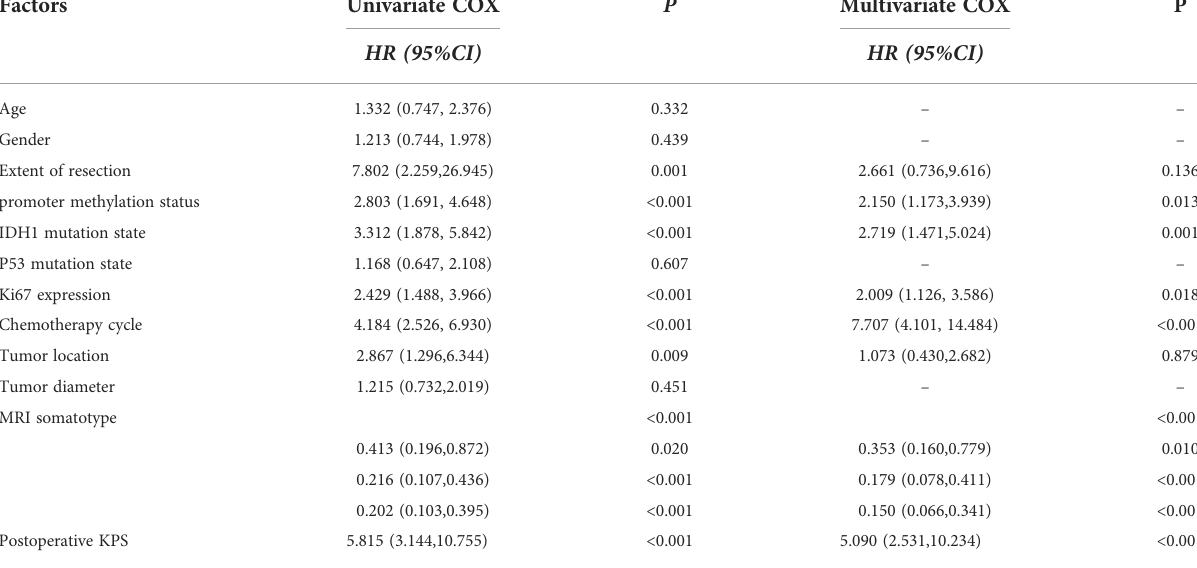
TABLE 4 Univariate and multivariate Cox proportional hazards model results for overall survival.